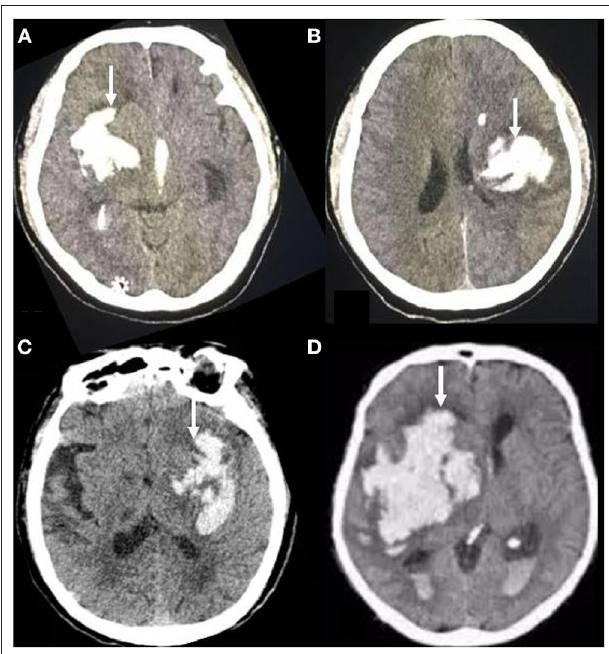
FIGURE 1 | Brain transverse CT section showing examples of hematoma shape. On the transverse CT scans of the brain, the irregular shape of hematoma showed different features, corresponding to grades III (A, B) or IV-V (C, D) of the Barras